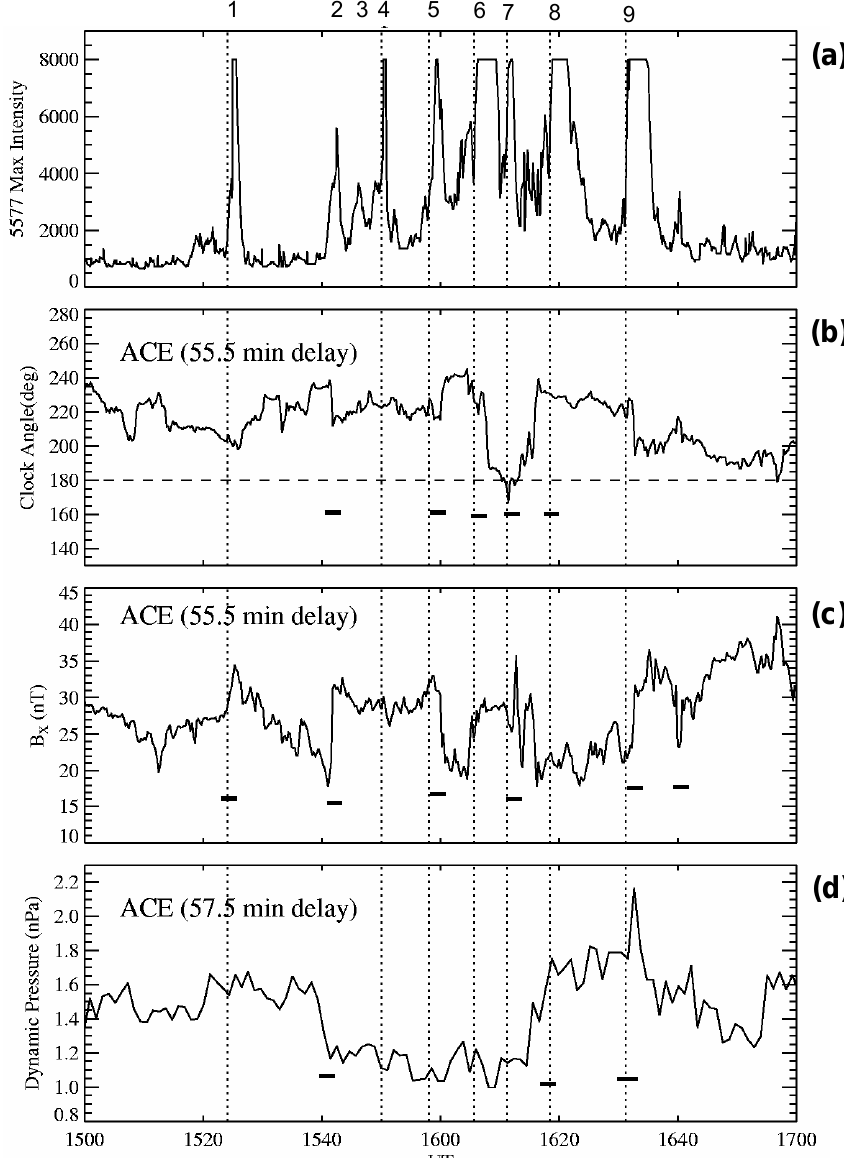
Fig. 7. Comparison of the maximum intensities (from Fig. 6) with possible solar wind drivers. An additional 2min lag was included in the dynamic pressure plot (d) since its interaction occur at sub-cusp latitudes on the magnetopause rather than near the rim of the northern hemisphere cusp where the IMF makes first contact. Vertical dotted lines mark the beginning of each major PMAF. Black bars note changes in the solar wind parameters that may have triggered or influenced the